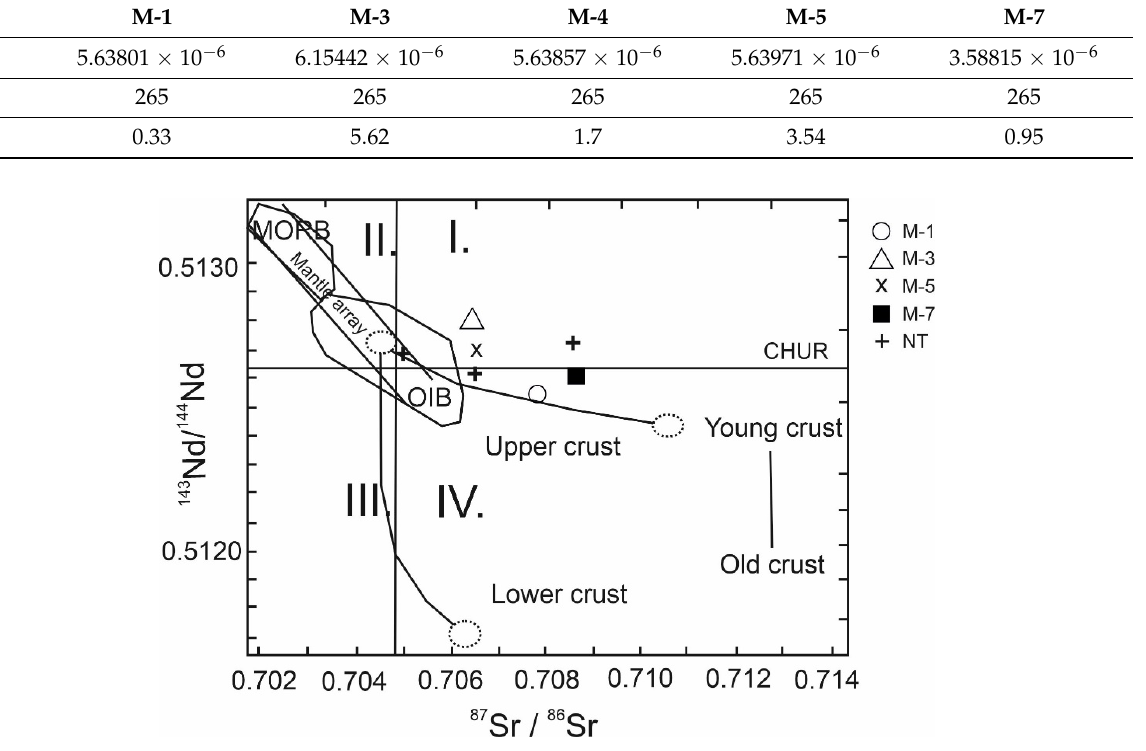
Figure 12. 143 Nd/ 144 Nd vs. 87 Sr/ 86 Sr discriminant diagram, CHUR—chondrite uniform reservoir; M7 from Table 8, NT—analyses of paleobasalts from Vozár et al. [61].